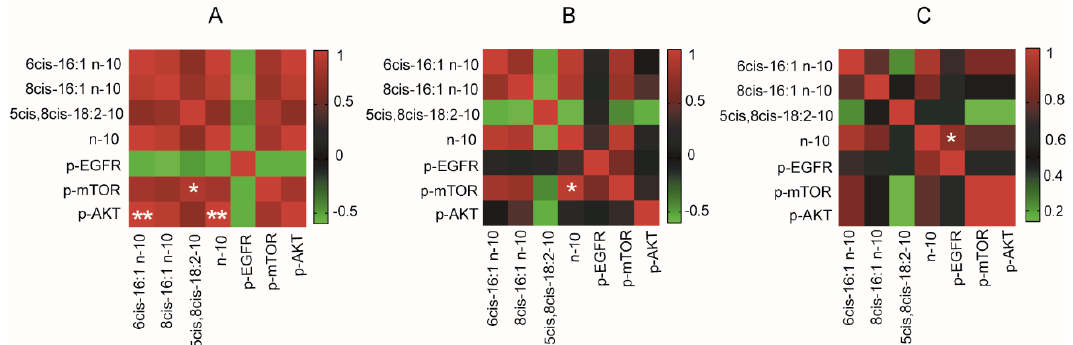
Figure 3. Heat maps of the correlations between n-10 fatty acids levels and signaling proteins activation in MCF-7 ( A ), MDA-MB-231 ( B ) and BT-20 ( C ) cell lines treated with 50 µ M sapienic acid; statistically significant correlations are indicated: * p -value < 0.05; ** p -value < 0.005.